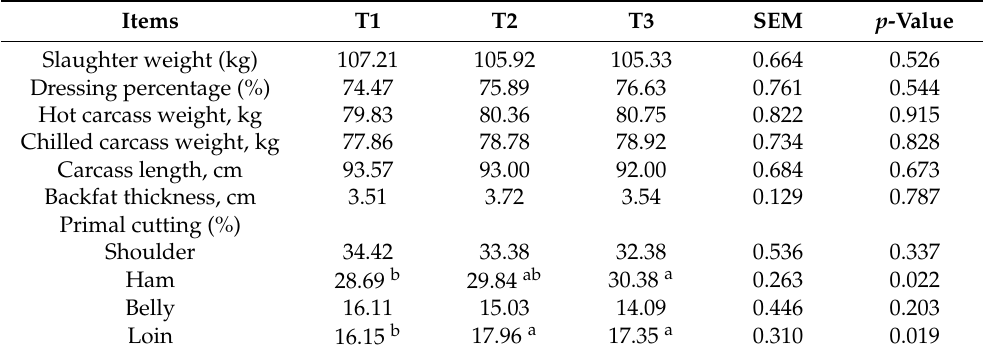
Table 4. Carcasses characteristic of a finishing crossbred pigs fed a low-lysine diet supplemented with perilla